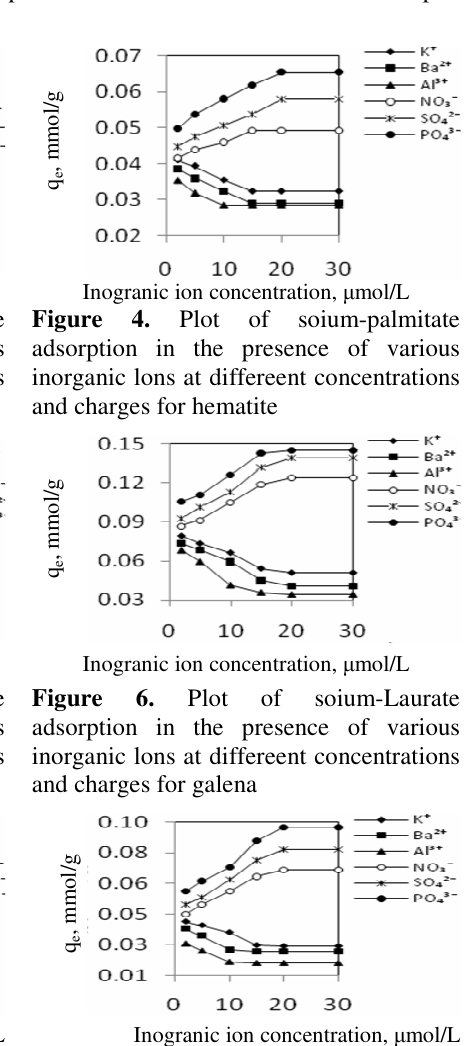
Figure 7. Plot of soium-Laurate adsorption in the presence of various inorganic lons at differeent concentrations and charges for hematite